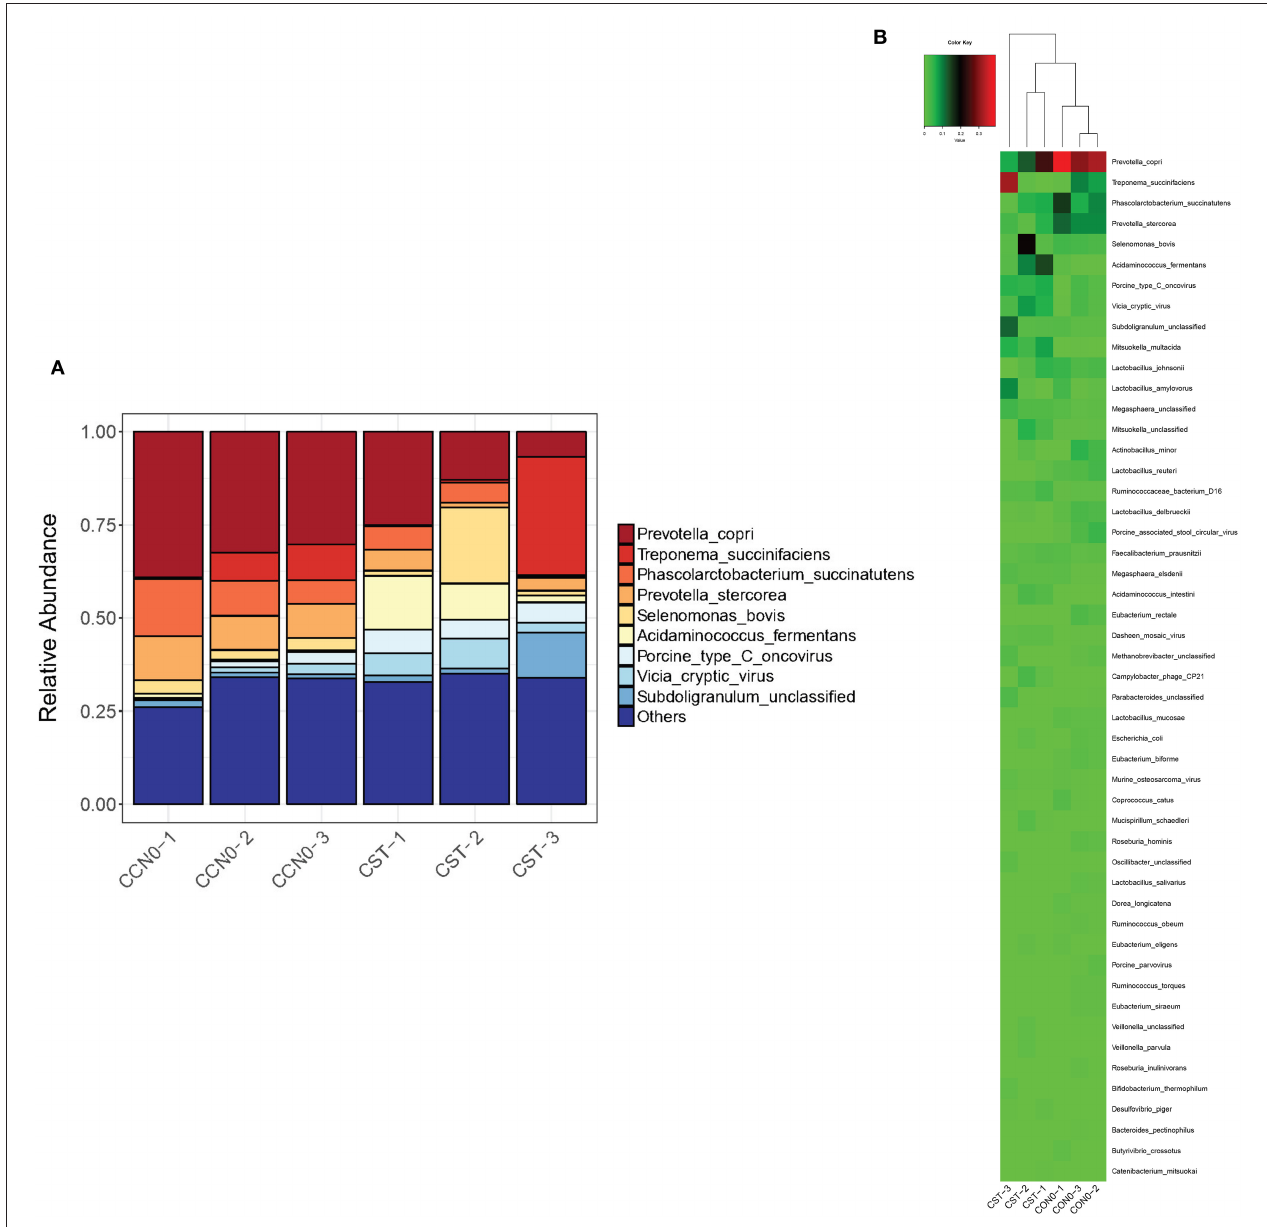
FIGURE 6 | Effects of colistin on microbiome composition changes at the species level displayed as a bar chart (A) and a heatmap (B) . The abundance of species is shown on the y axis. Group 1, control group; group 2, colistin